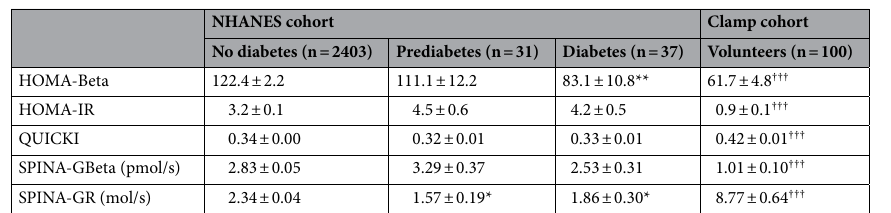
Table 3. Biomarkers of insulin-glucose homeostasis in subjects with diabetes, prediabetes and no diabetes of the NHANES cohort and in lean healthy volunteers of the Clamp cohort. Shown are means ± SEM. p * < 0.05, ** < 0.01 compared to subjects without diabetes (comparisons for NHANES cohort only). ††† p < 1e–15 for the comparison of the